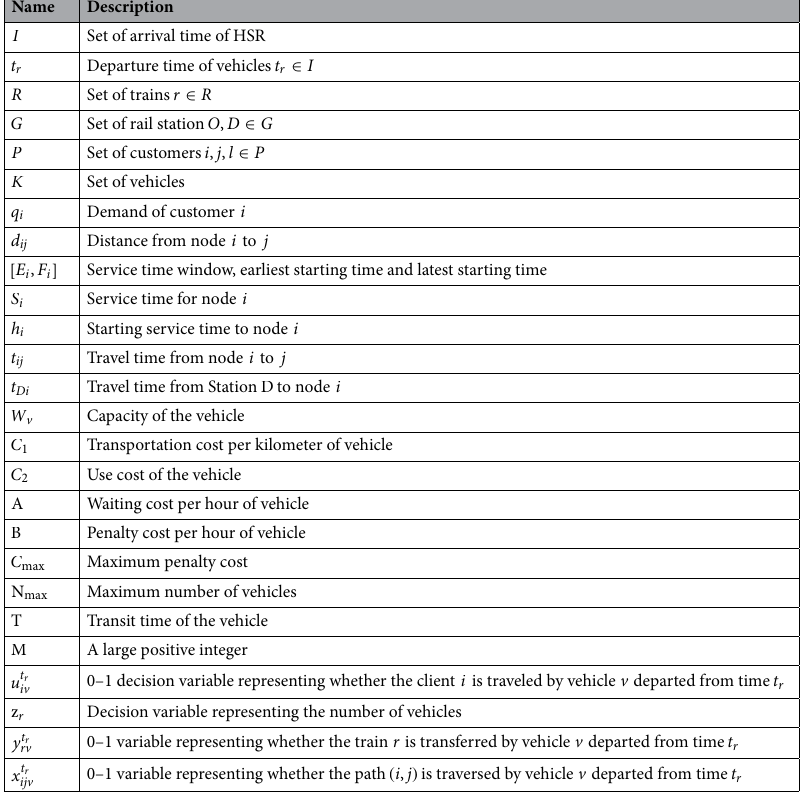
Table 1. Definitions of